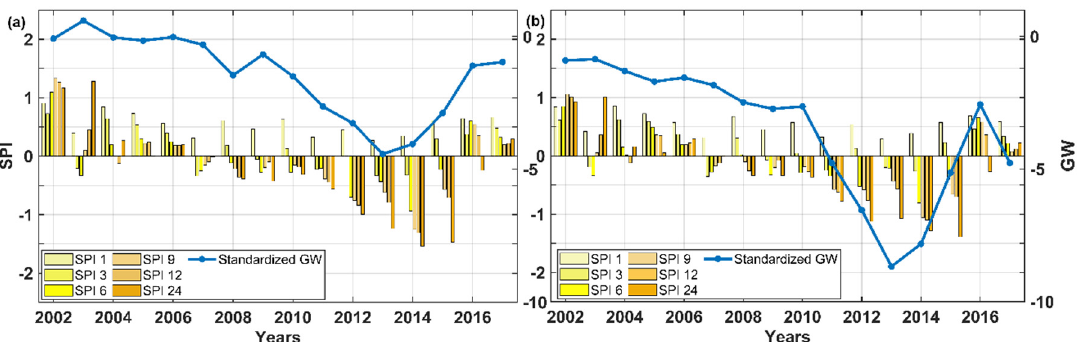
Figure 8. Annual standardized GW and annual SPI at different scales in ( a ) Petorca watershed and ( b ) Ligua watershed from 2002 to 2017.